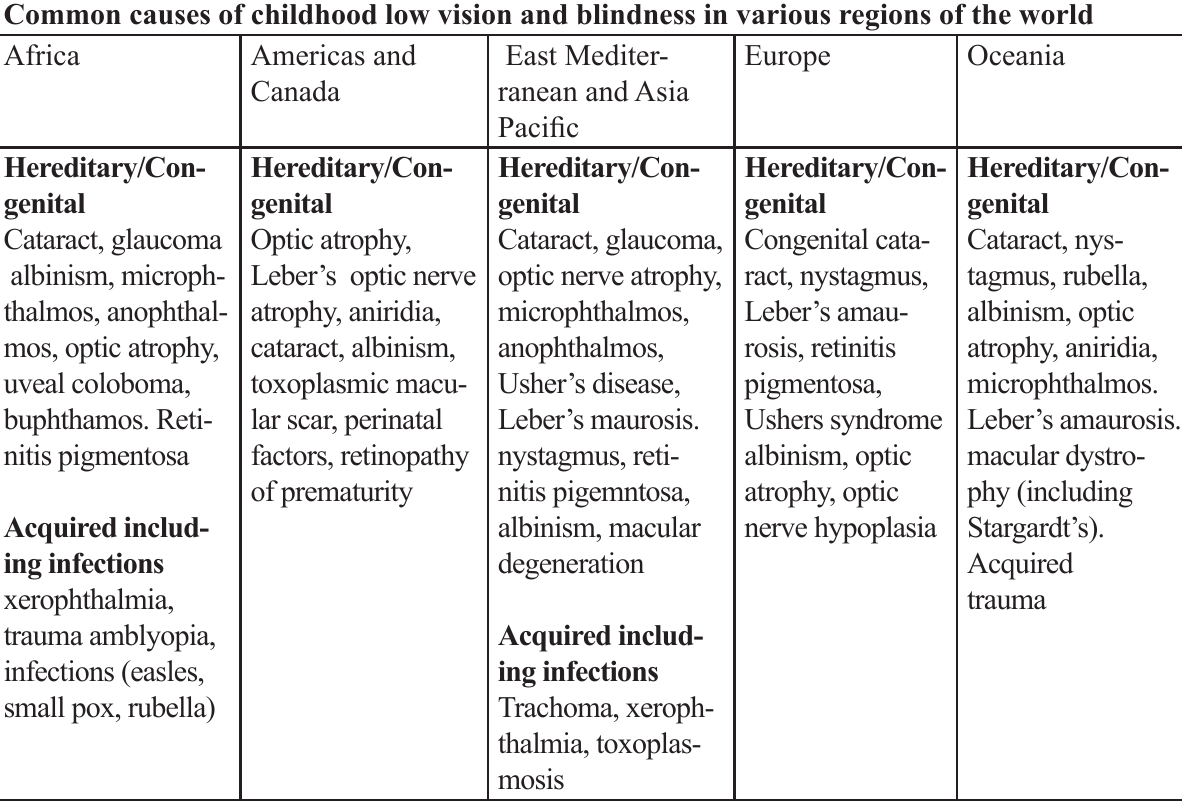
Table 2. Causes of Childhood low vision and blindness in different parts of the